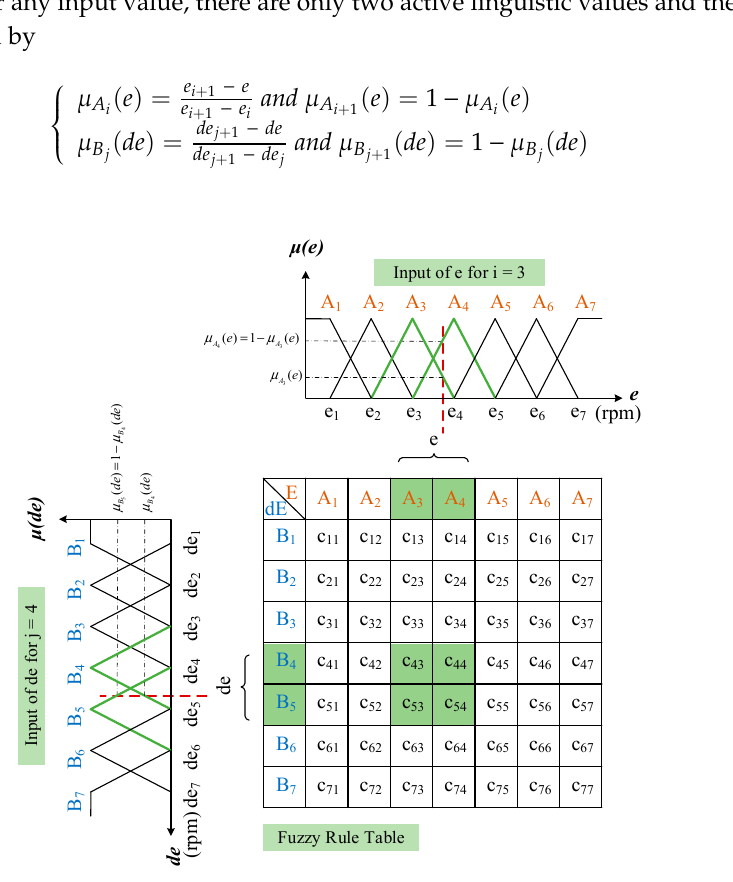
Figure 5. The membership function of e, de and fuzzy rule table.